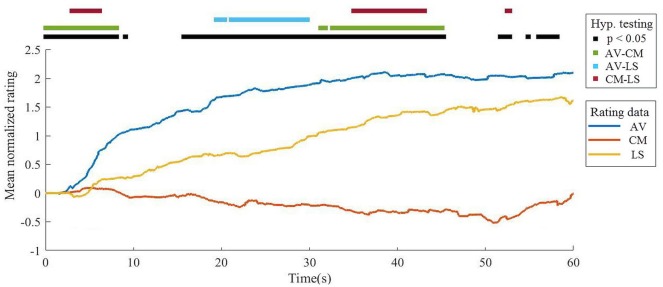
Comparison of mean accumulated normalized ratings (ANRs) by video. AV, adventure video; CM, comedy video; LS, landscape video.